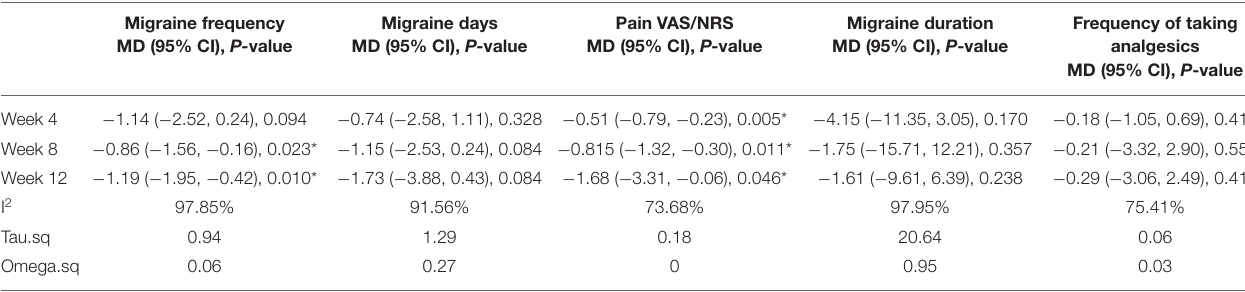
TABLE 4 | Meta-analyses using robust variance estimation model with small-sample